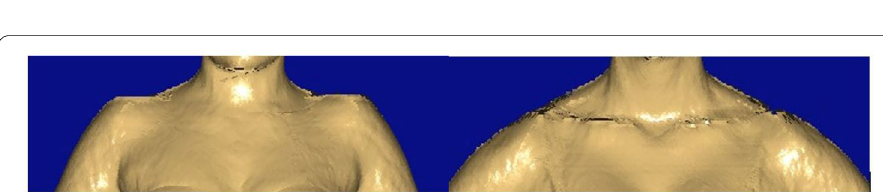
Fig. 8 Examples of shoulder point sharpness, from left: sharp, smooth